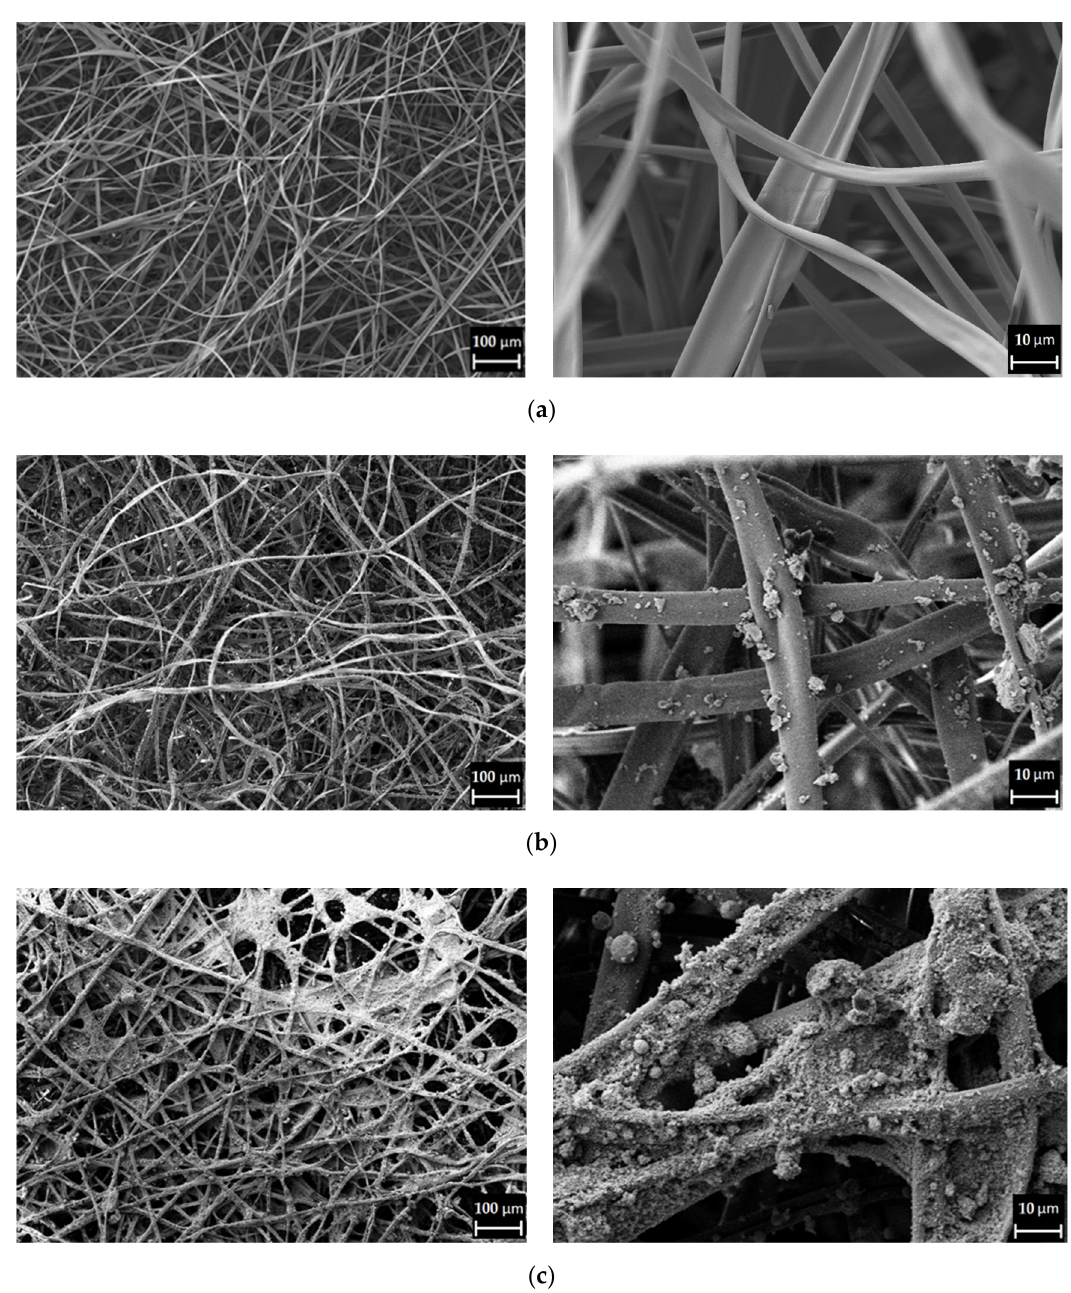
Figure 5. SEM images of the different electrospun fibre materials: ( a ) pure CA; ( b ) CA/AC; ( c ) CA/TiO 2 . The composite filter is a combination of the previous two CA/TiO 2 and CA/AC filters. SEM images of the four steps to fabricate each layer of the filters are shown in Figure 6. The presence of additives is clearly visible on the fibre surface on the second and fourth layers in the form of agglomerates.